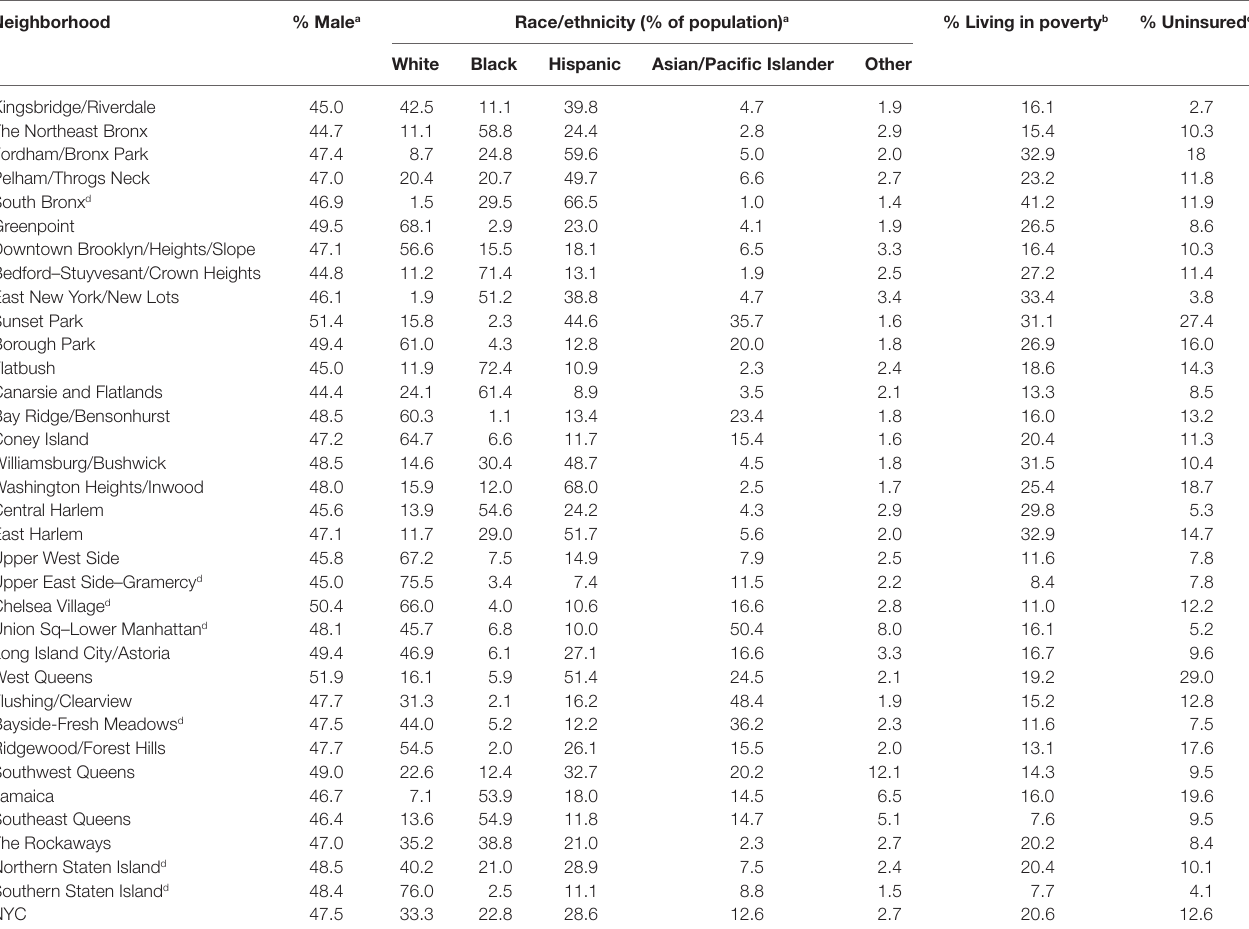
TaBle 1 | Distribution of sociodemographic characteristics according to neighborhood. neighborhood % Male a race/ethnicity (% of population) a % living in poverty b % Uninsured c White Black hispanic asian/Pacific islander Other Kingsbridge/Riverdale